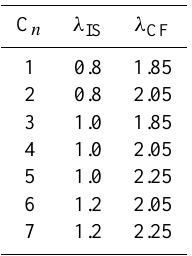
Fig. 10a. Pie charts with statistics of detections within 3-h long TDI are shown for all the 7 configurations of Table 4 ordered as in a ma- trix. For each pie chart the corresponding values of λ IS and λ CF can be read on the left and on the bottom. The following four cat- egories are shown: (m) number of records with missed detection, (S+T) number of records with detections by both tsunami detec- tion and secure detection methods, (S) number of records with de- tection only by the secure detection method, (T) number of record with detection only by the tsunami detection method. The inner part of each pie chart shows for each of the above categories if there are false detections (black) or not (white) in the records. The area of black sectors is proportional to the number of records with false detections.